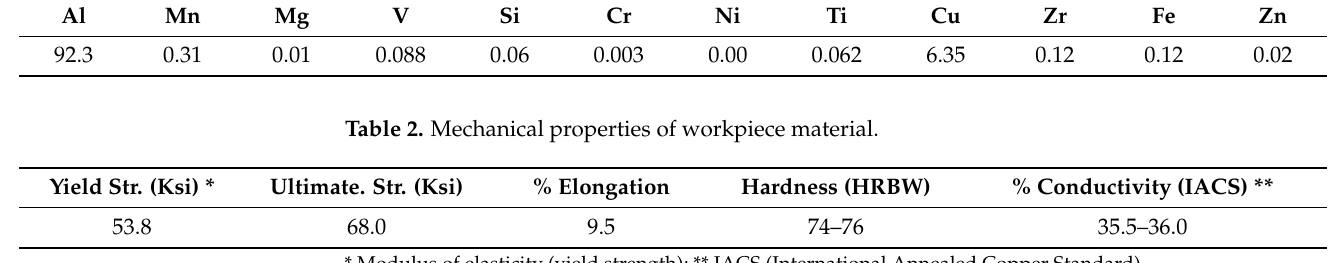
Table 1. Chemical composition of workpiece material.